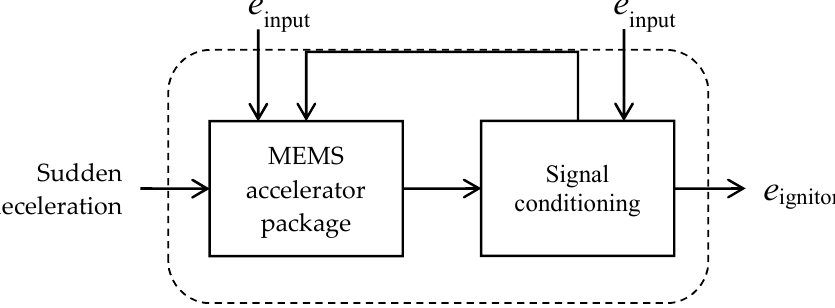
Figure 1. Accelerometer sensor system in an airbag system [4]. MEMS, microelectromechanical systems.